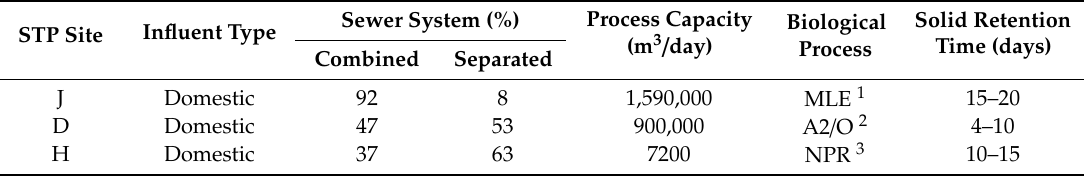
Table 1. Summarized information on sewage treatment plant (STP) facilities from which sewage sludge samples were taken.